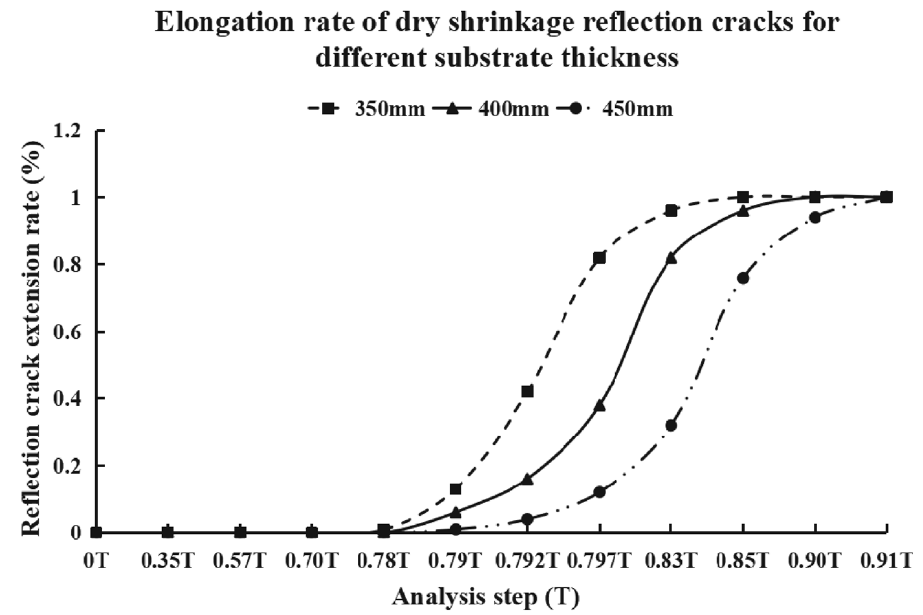
Fig. 9 Elongation rate of dry shrinkage reflection cracks for different substrate